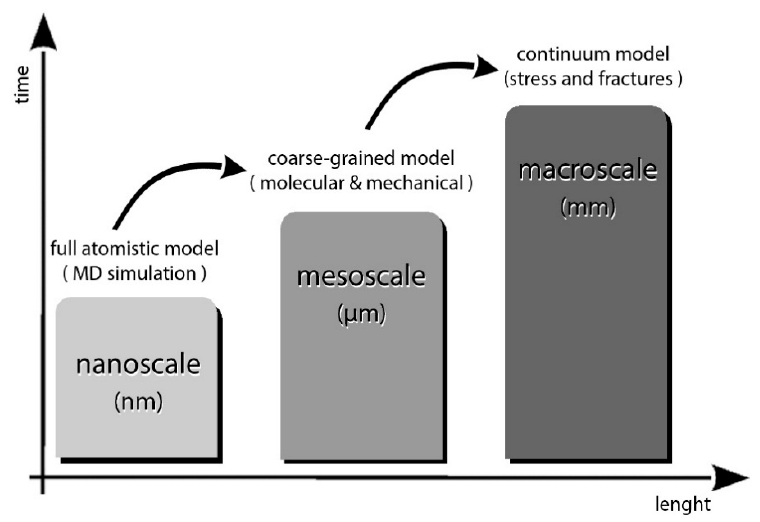
Figure 12. Multiscaling process from molecular dynamics to a continuum theory passing by coarse-grained models for mechanical and dynamical simulations.